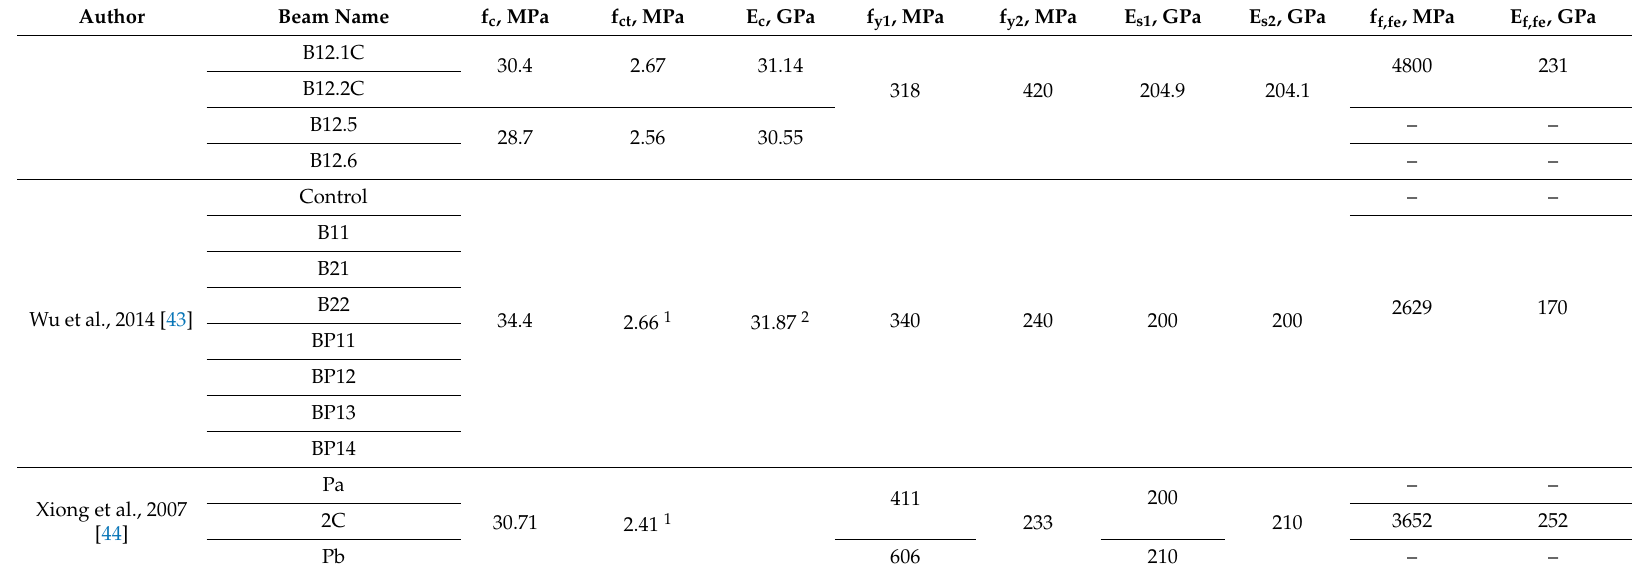
c —modulus of elasticity of the concrete material; f y1 —yielding strength of the tensioned steel bars; f y2 —yielding strength of the compressed steel bars; E s1 —modulus of elasticity of the tensioned steel bars; E s2 —modulus of elasticity of the compressed steel bars; f f,fe —tensile strength of tensioned fibers or FRP; E f,fe —modulus of elasticity tensioned fibers or FRP; *—calculated by the law of the